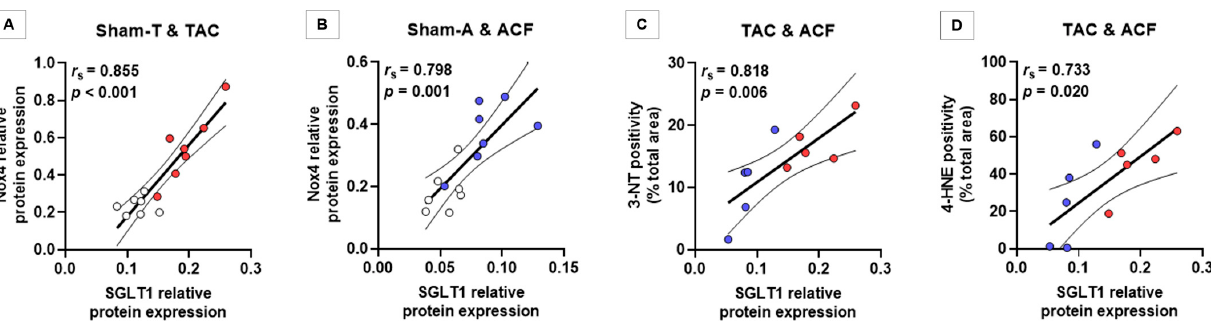
Figure 5. Correlation between left ventricular SGLT1 protein expression, Nox4 protein expression and the extent of myocardial nitro-oxidative stress. ( A , B ) Spearman correlation analysis of left ventricular (LV) sodium-glucose cotransporter 1 (SGLT1) protein expression and nicotinamide adenine dinucleotide phosphate (NADPH) oxidase isoform Nox4 protein expression in the Sham-T and pressure-overloaded (TAC), and Sham-A and volume-overloaded (ACF) groups. ( C ) Spearman correlation analysis of western blot-derived LV SGLT1 protein expression and myocardial 3-nitrotyrosine (3-NT) positivity (expressed as percentage of the total area) assessed by immunohistochemical analysis in rats with pressure and volume overload-induced heart failure (TAC and ACF). ( D ) Spearman correlation analysis of western blot-derived LV SGLT1 protein expression and myocardial 4-hydroxy-2-nonenal (4-HNE) positivity (expressed as percentage of the total area) assessed by immunohistochemical analysis in rats with pressure and volume overload-induced heart failure (TAC and